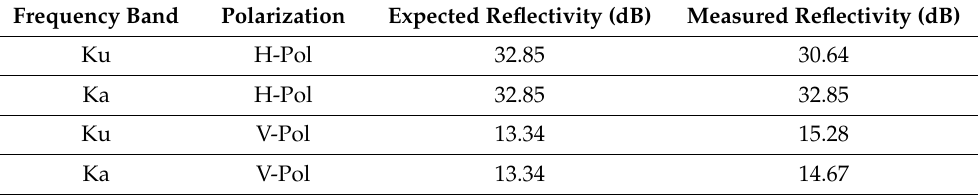
Figure 7. Peak reflectivity values corresponding to the metal spheres used for calibration, the sphere is located at 1.95 km from the radar. ( a ) Ku H pol data; ( b ) Ku V pol data; ( c ) Ka H pol data; and ( d ) Ka V pol data. Table 3. Results of the calibration experiment.